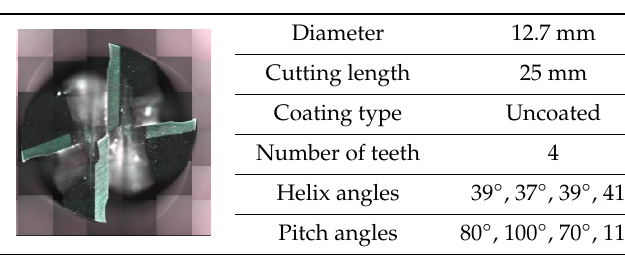
Figure 5. Scheme of the experimental setup for ( a ) the modal analysis and ( b ) cutting forces characterization.